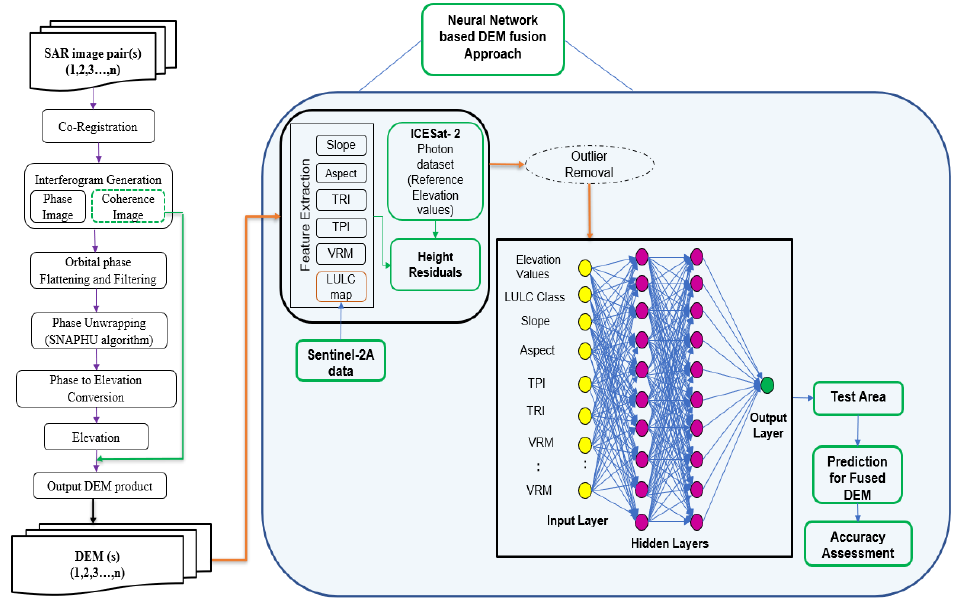
Figure 2. Workflow of the Neural Network-based Fusion Framework for DEM Improvement .